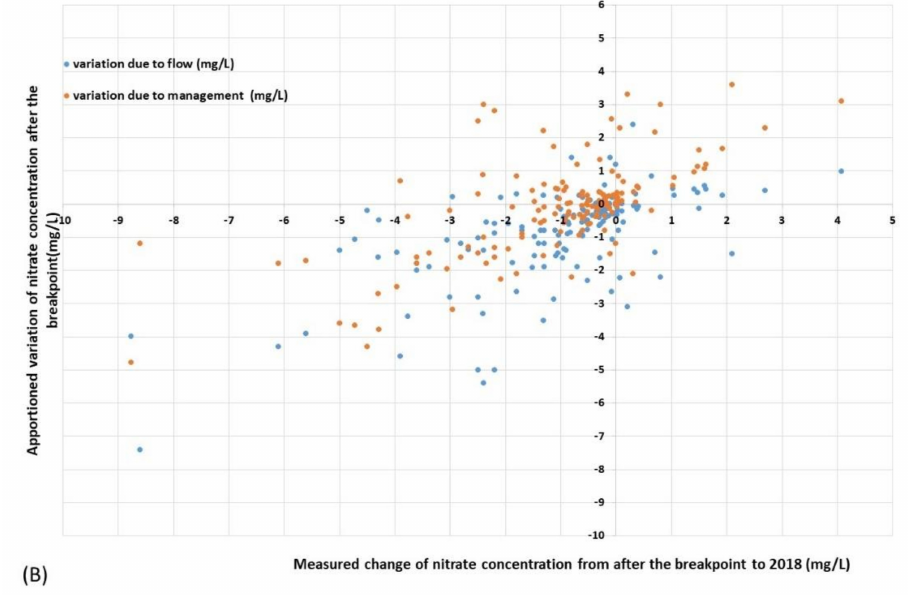
Figure 6. Impact of flow and management on the variation of the nitrate concentrations for the period 1990–2017 ( A ). Impact of flow and management on the variation of the nitrate concentrations after the breakpoint ( B